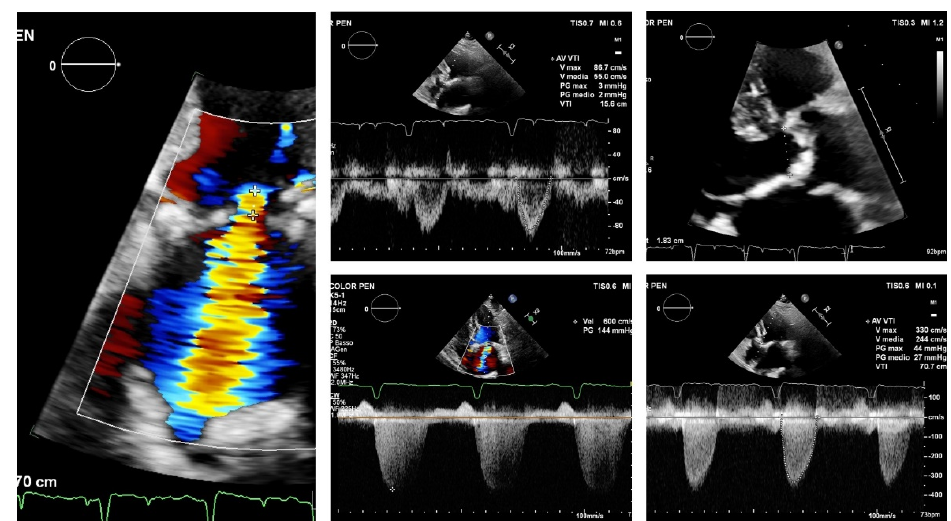
Figure 1. An elderly woman with low-gradient severe AS associated with MR and preserved ejection fraction. The MPG is 27 mm Hg and the Vmax is 330 cm/s. The left ventricular outflow tract’s pulsed wave Doppler velocity-time integral and diameter are 15.6 cm and 1.8 cm, respectively. The calculated SVI is 40 mL (24 mL/m 2 ) and AVA is 0.58 cm 2 . The EROA by the 2D-PISA method is 0.20 cm 2 , Rvol = 37 mL. Of note, the MR jet velocity is 6 m/s because jet momentum flux (which is flow • v or EROA • v2) determines the color Doppler jet area. A 6 m/s jet shows 44% larger than a 5 m/s jet through the same EROA. AS: aortic stenosis; MR: mitral regurgitation; MPG: mean transaortic pressure gradient; Vmax: maximal transaortic velocity; SVI: stroke volume index; AVA: functional aortic valve area; v: velocity. 2D: bi-dimensional echocardiography; PISA: proximal isovelocity surface area; RVol: regurgitant volume; EROA: effective regurgitant orifice area. Table 1. Conventional echocardiographic parameters’ challenges and possible solutions multimodality and advanced imaging. MR: mitral regurgitation; AS: aortic stenosis; LVEF: left ventricular ejection fraction; LV: left ventricle; Rflow: regurgitant flow; Rvol: regurgitant volume;